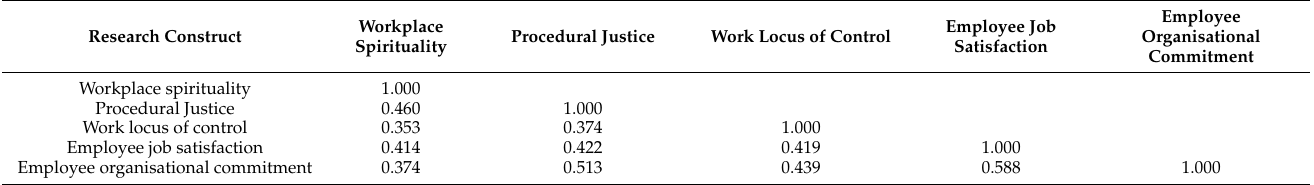
Table 3. Discriminant validity